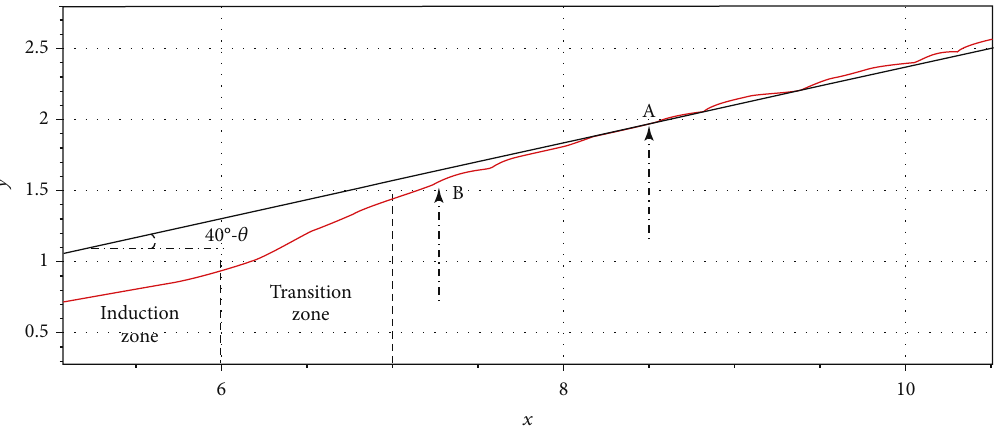
= 30 at time t = 15 . A